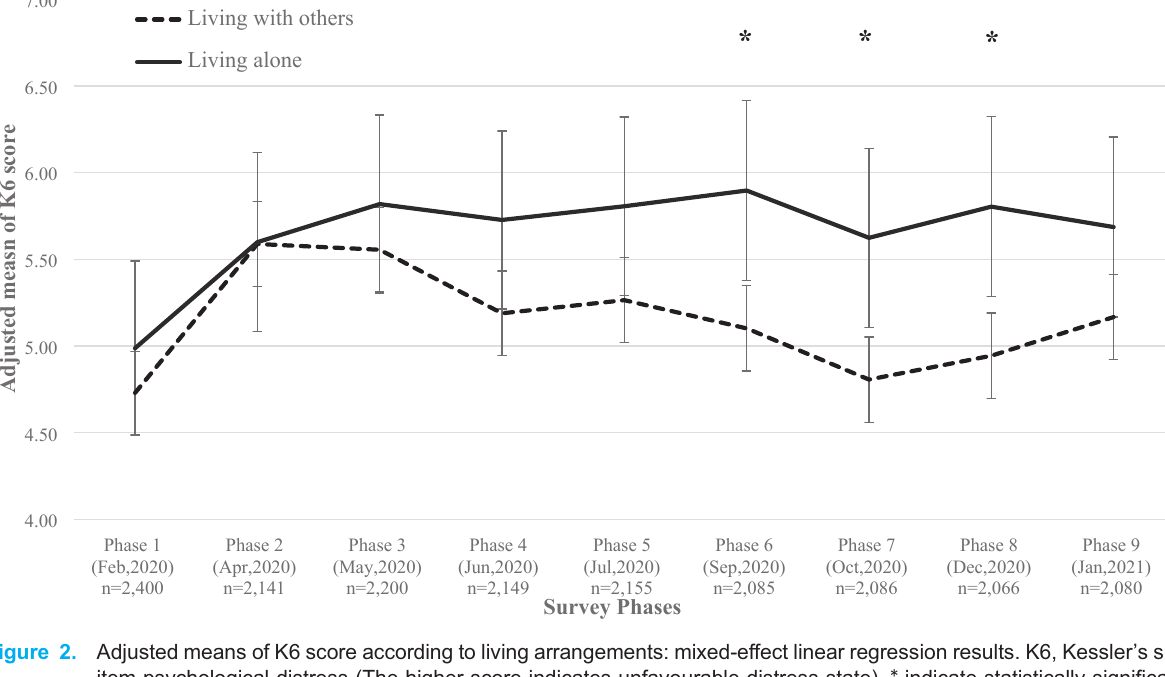
Figure 2. Adjusted means of K6 score according to living arrangements: mixed-e ff ect linear regression results. K6, Kessler ’ s six- item psychological distress (The higher score indicates unfavourable distress state). * indicate statistically signi fi cant results in 5% signi fi cance levels, respectively. All mean values were adjusted by gender, age, residential area (prefecture), working status, personal annual income, education, smoking status, alcohol consumption, walking time, number of comorbidities (none, 1, 2 + ), and regular vaccination. Error bar indicate 95% con fi dence intervals.